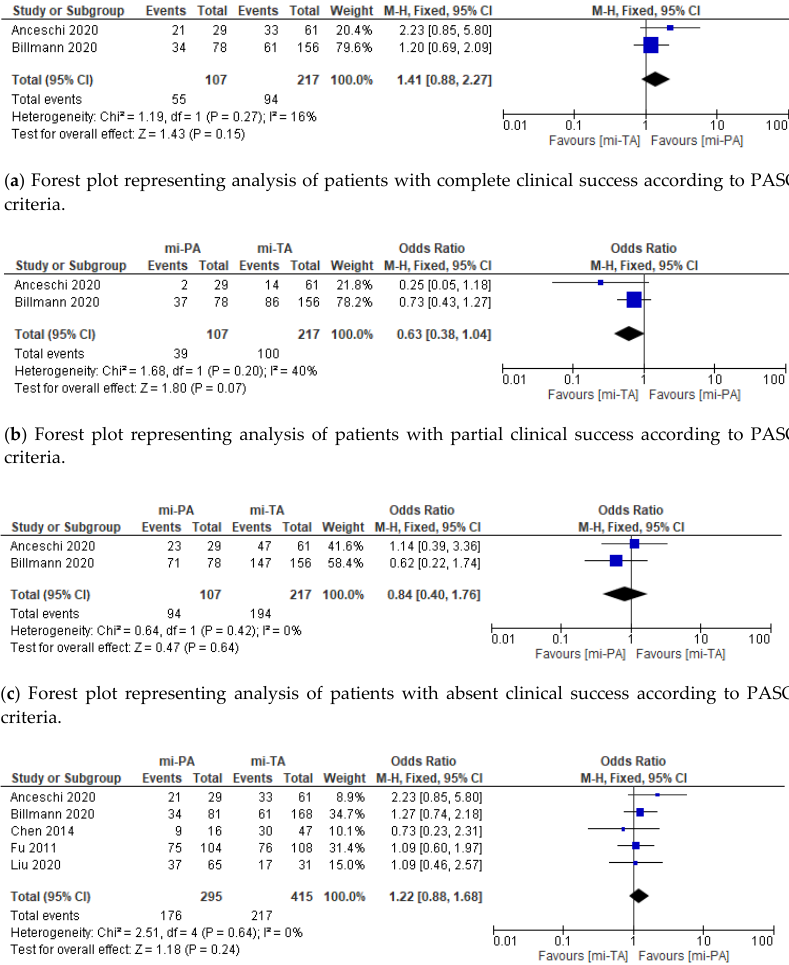
( f ) Forest plot representing analysis of postoperative SBP (mmHg). ( g ) Forest plot representing analysis of postoperative DBP (mmHg). ( h ) Forest plot representing analysis of postoperative mean potassium serum levels (mmol/L).